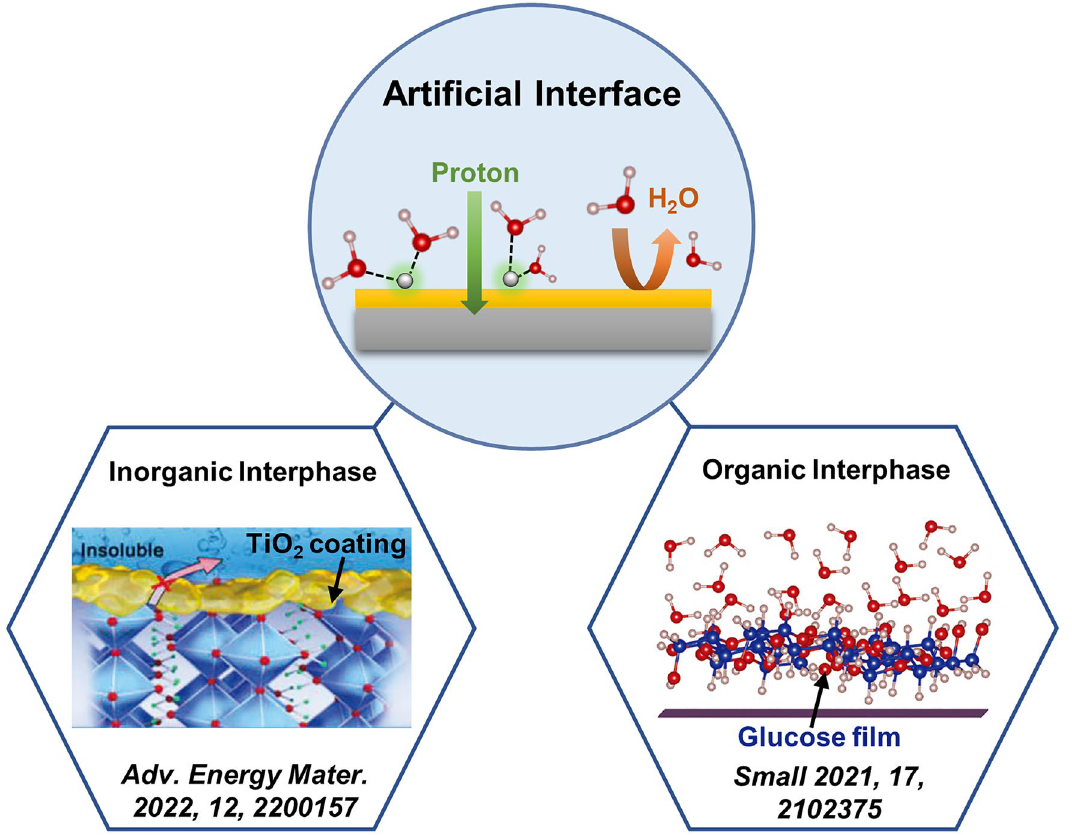
Fig. 3 Schematic diagram of the design of electrode interphase to improve electrode stability and interface reaction